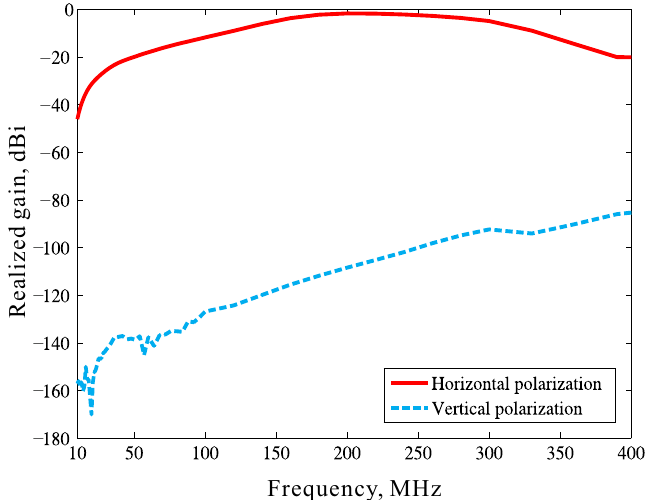
Figure 10. Simulated realized gain of a proposed antenna on the + z −